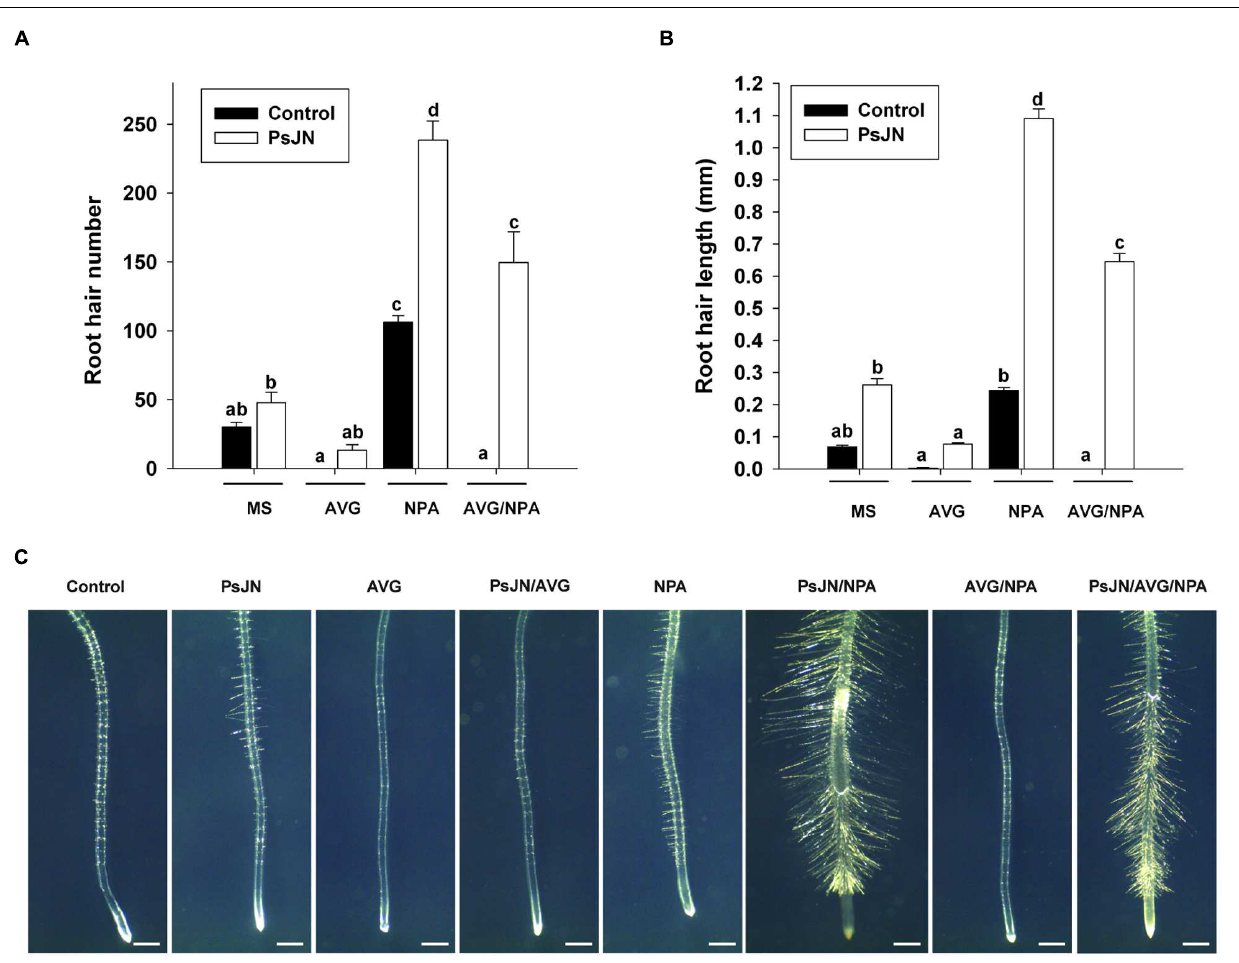
FIGURE 5 | Effects of B. phytofirmans PsJN in root hair number and length under auxin transport and/or ethylene biosynthesis inhibition. Graphic representation of the root hair number (A) and hair length (B) of root tips (5 mm) from plants inoculated (PsJN) or not (control) with B. phytofirmans PsJN. Plants were also grown without chemical inhibitors (MS), or under the treatment with the auxin efflux inhibitor NPA ( N -1-naphthylphthalamic acid) at 2 µ M and/or with the ethylene biosynthesis inhibitor amino ethoxyvinyl glycine hydrochloride (AVG; Fluka Sigma–Aldrich) at 1.5 µ M. Data are means ± SE of at least 20 plants per treatment. Lowercase letters on top of the bars (a–d) indicate significant statistical differences among treatments. Bars that do not share an identical letter have significant differences, according to a Two-way ANOVA analysis ( p < 0.05), considering inoculation and chemical treatments as factors, and a Tukey post hoc test ( p < 0.05). Results are representative of three different experiments. Representative photographs of each treatment are presented in (C) ; white bars in photographs correspond to 1